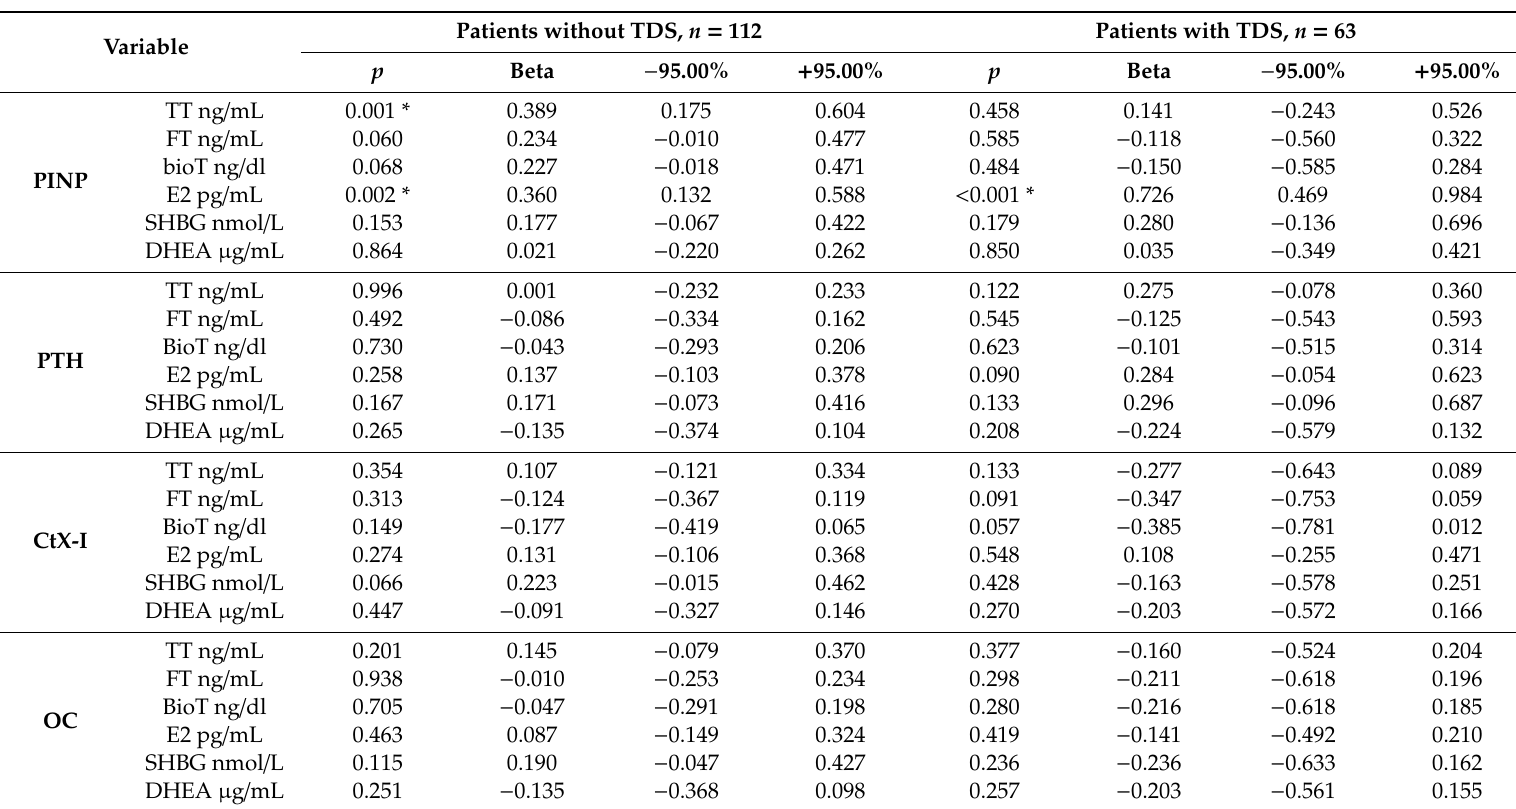
Table 2. Multivariate linear regression analysis of the levels of hormonal parameters and proteins and the parameters of bone turnover in the groups with and without TDS. The results were adjusted for age and